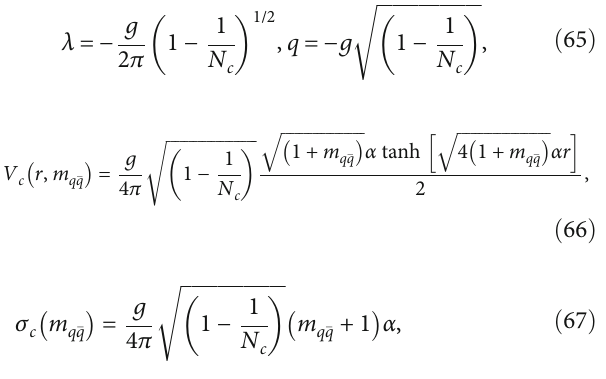
ffiffiffi p 2 Þ ,